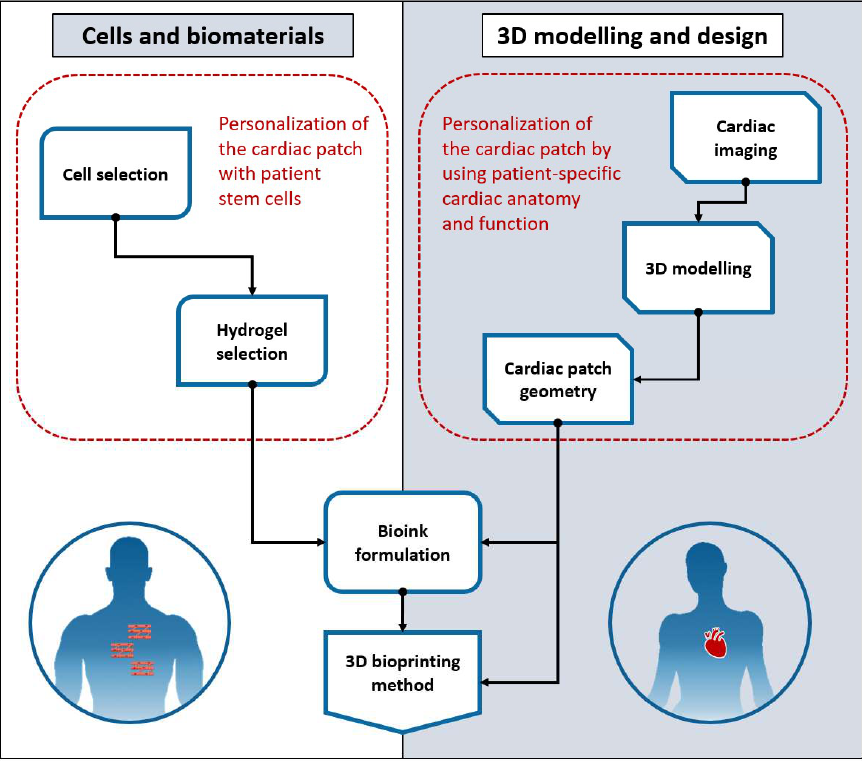
Figure 1. Biological and 3D design considerations of creating a personalised cardiac patch; the red border indicates components that can be matched closest to patient specifics. Selection of cells and hydrogels is a critical design component as the use of patient stem cells forms a biological basis for creating a personalised patch. The resulting bioink formulation must support cell viability and function. Anatomical and functional characteristics of the heart are captured from cardiac imaging data and used to create a patient-specific 3D cardiac model. The design geometry of the cardiac patch is based on the personalised cardiac 3D model. The shape, the size and the thickness of the patch impact the bioink formulation and the selection of the 3DBP method